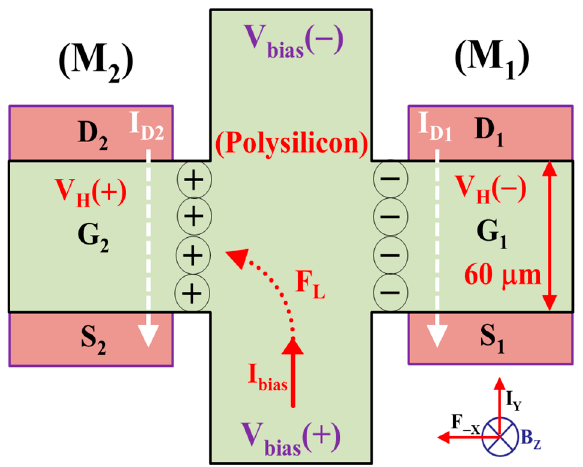
Figure 1. Strip MAGFET with two separated MOSFETs and a differential polysilicon CSHP. The Lorentz force F L not only pushes the positive charge ⊕ to the left to gather at the left side of the polysilicon CSHP, but also injects the electron current (cid:9) into the right side of the polysilicon CSHP to reduce the drain current of the first MOSFET ( I D 1 ).